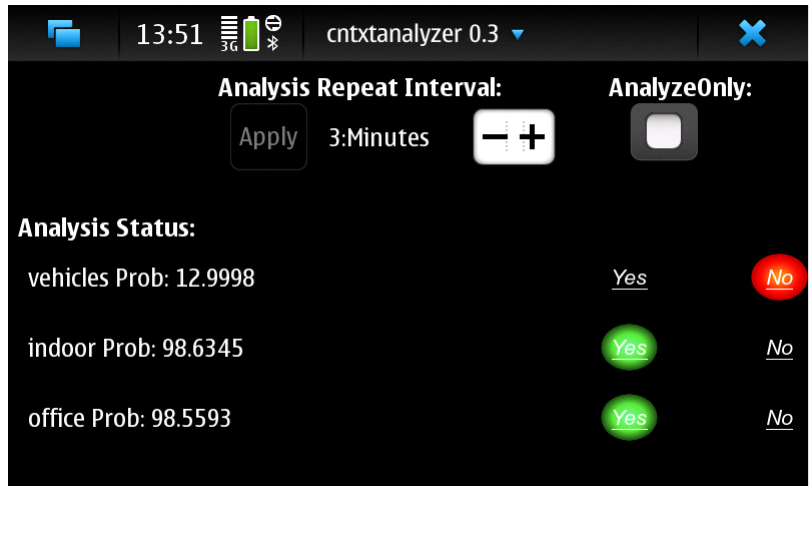
Figure 2. During the second trial, user were able to give input on whether the classification was correct or